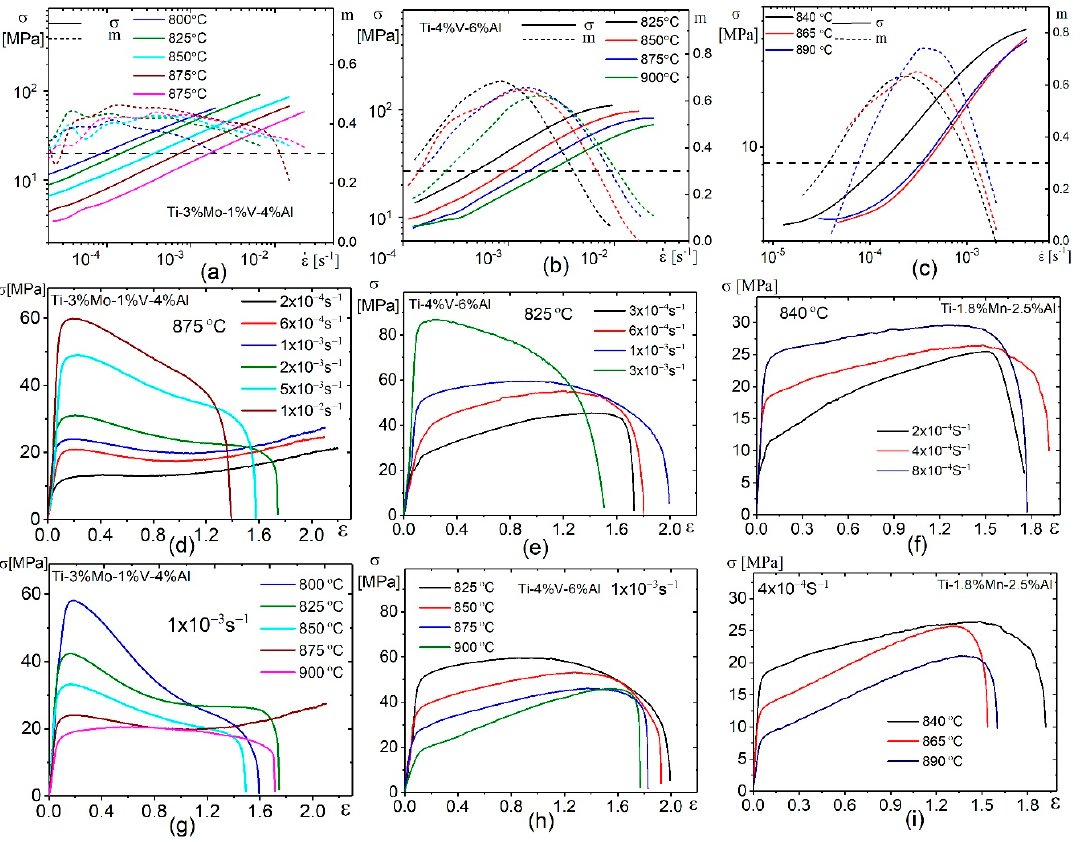
Figure 3. The results of the tensile tests of the tested alloys at various temperatures and strain rates: Ti-3%Mo-1%V-4%Al alloy ( a , d,g ); Ti-4%V-6%Al alloy ( b , e,h ); and Ti-1.8%Mn-2.5%Al alloy ( c , f,i ). Ti-3%Mo-1%V-4%Al alloy ( a , d , g ); Ti-4%V-6%Al alloy ( b , e , h ); and Ti-1.8%Mn-2.5%Al alloy ( c , f , i